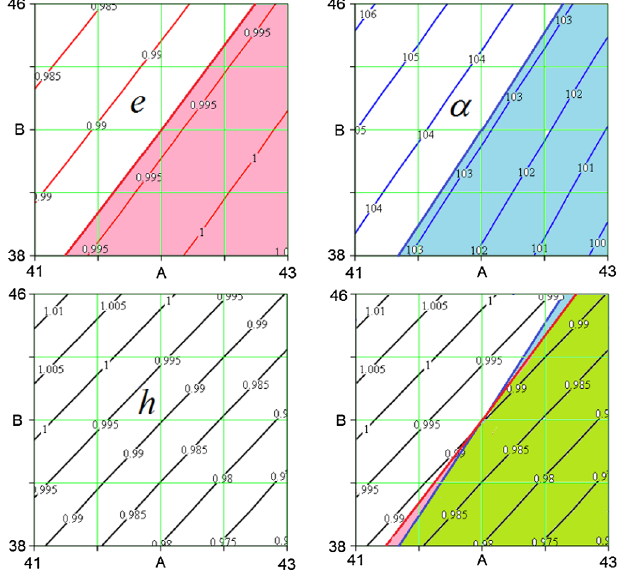
FIG. 8. Map for the original TESLA cavity. a ¼ 12 mm, b ¼ 19 mm, β ¼ 1 .